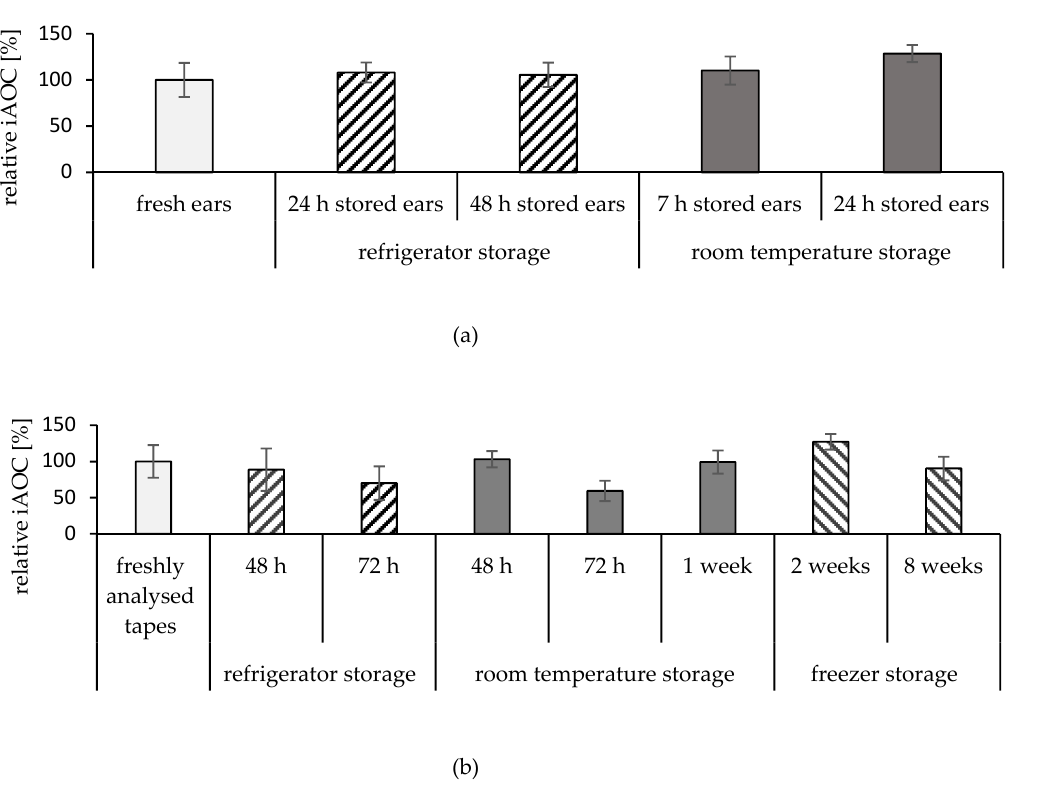
Figure 6. Influence of storage under different conditions on iAOC; ( a ) ear storage up to 48 h and ( b ) tapes storage up to 8 weeks.